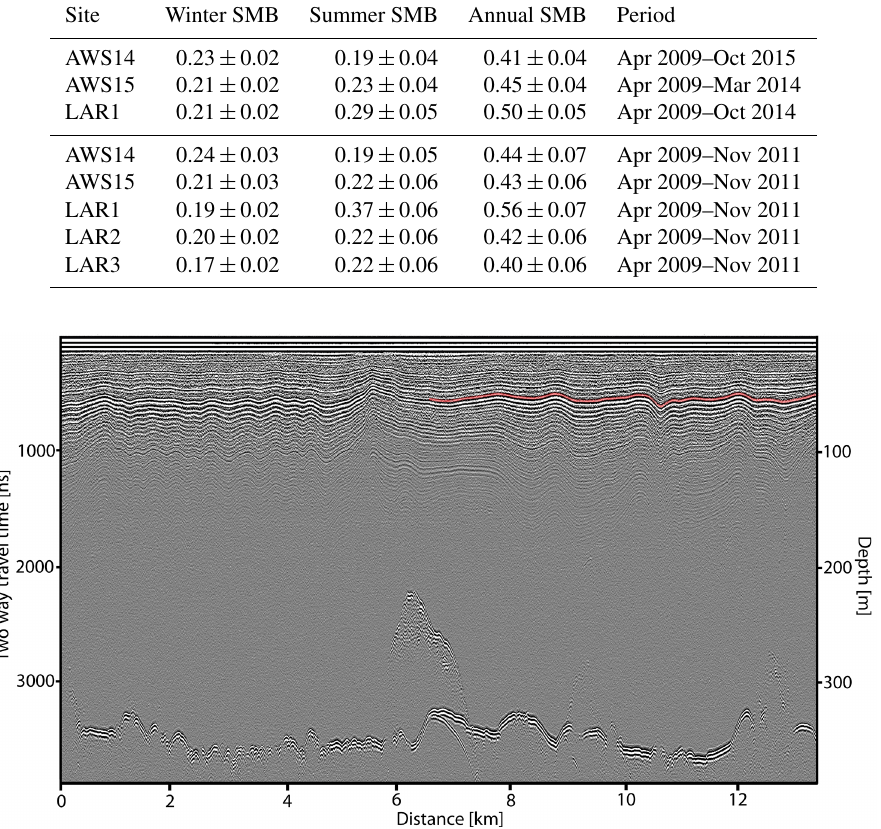
Figure 6. Example radargram from ground-penetrating radar, with the reflection horizon at 35–45m below the surface clearly visible, partly indicated with a red line. The lowermost reflections are from the ice–ocean interface at about 350m